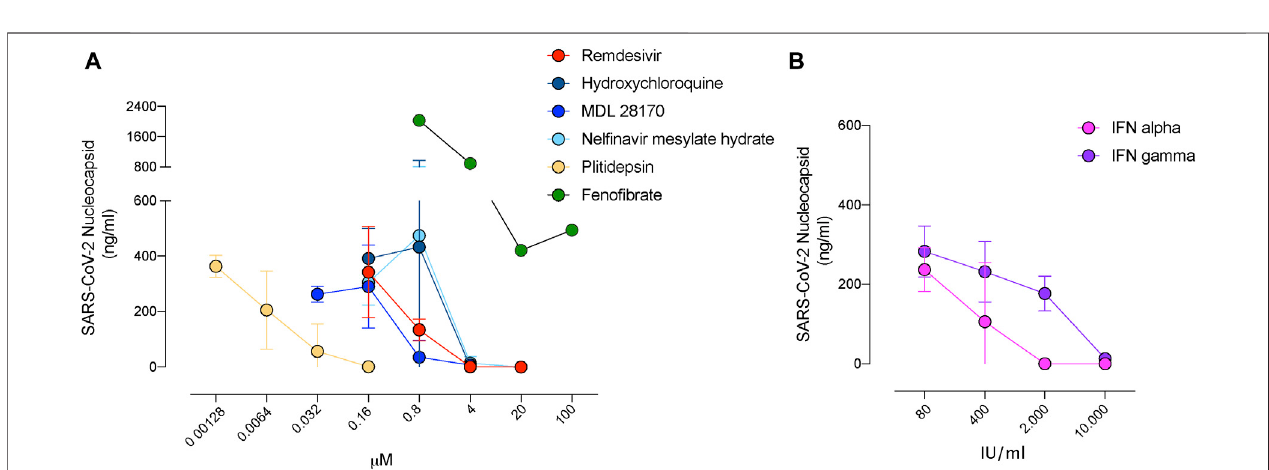
FIGURE 4 | Decreased release of SARS-CoV-2 in the presence of inhibitors with antiviral activity. (A) . Viral release to the supernatant in the presence of the indicated compounds added at increasing concentrations 3 days post-infection of Vero E6 cells. SARS-CoV-2 nucleoprotein was detected with an ELISA at concentrations were drugs were nontoxic. Mean and s.e.m. from two experiments. (B) . Viral release to the supernatant in the presence of the indicated interferons as described in A. Mean and s.e.m. from one experiment.